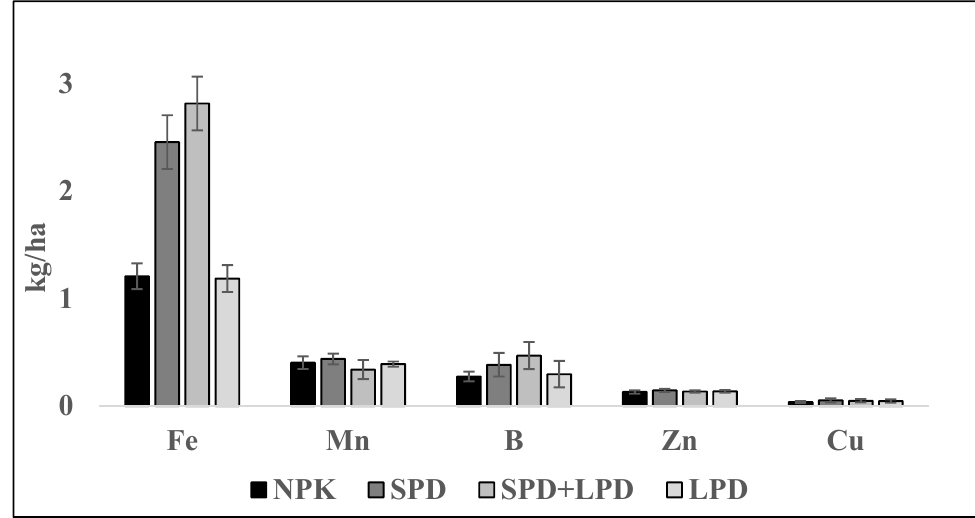
Figure 3. The average intakes of cannabis micronutrients of individual experimental variants (kg/ha).